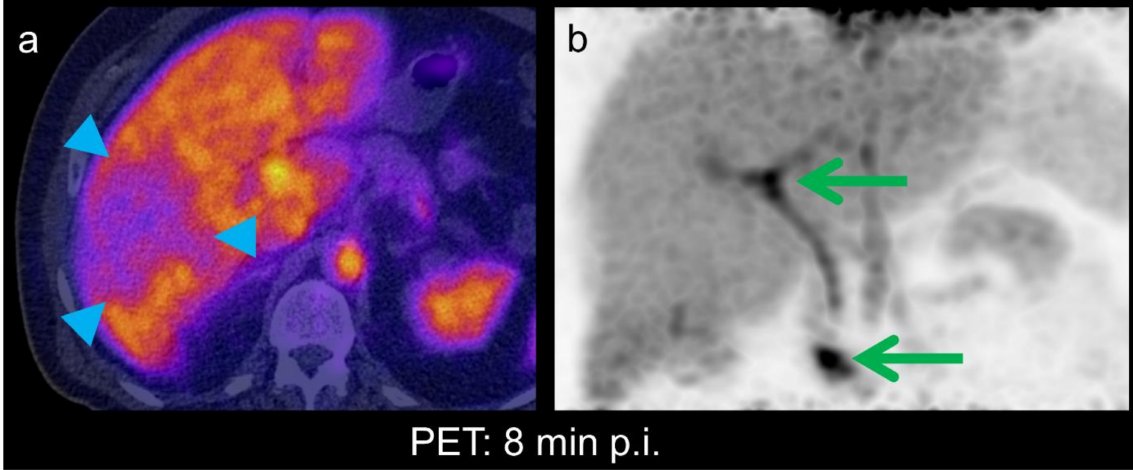
Figure 4. Liver function in a hepatocellular carcinoma (HCC) depends on the degree of dedifferentiation, substrate uptake, processing and bile excretion still taking place in well and moderately differentiated HCCs [7]. On PET/CT acquired in the hepatobiliary phase, eight minutes after injection, tumor uptake was approx. In this case, 50% of normal liver tissue, consistent with reduced but not absent cellular function ( a , arrowheads). Tracer excretion into bile ducts and duodenum can be seen on the corresponding maximum intensity projection (MIP) image ( b , green arrows). The tumor itself is barely visible due to the overlying liver tissue. In summary, the features were suggestive of an HCC. The patient underwent surgery. Histopathological examination showed a moderately differentiated